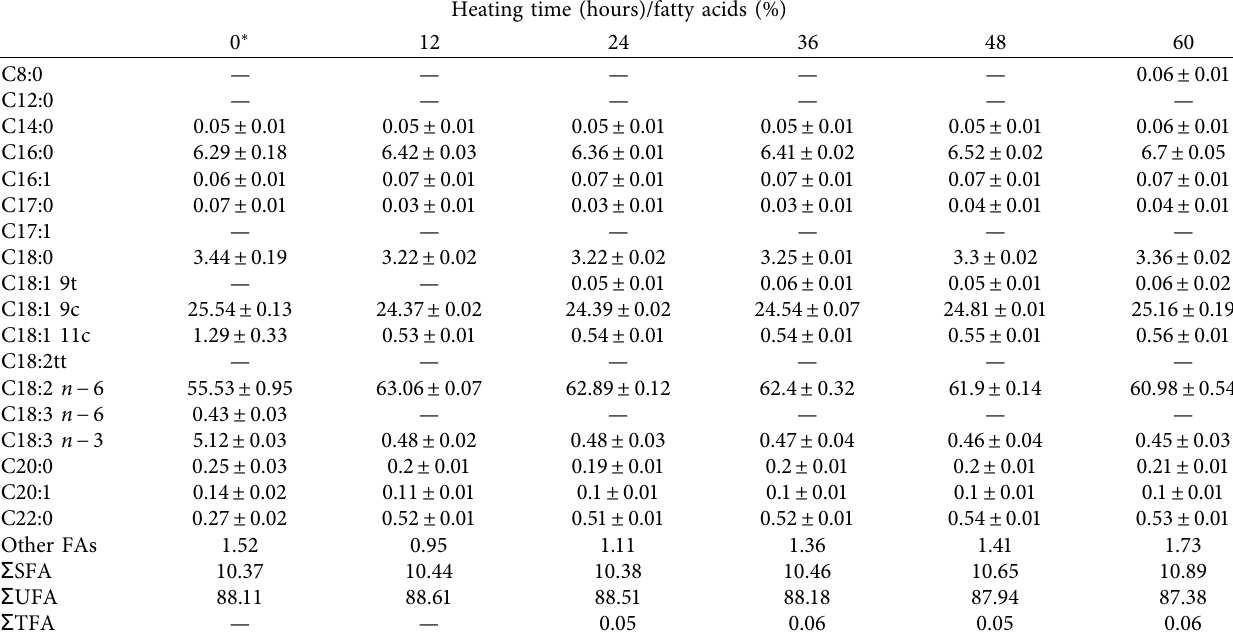
Table 2: Variation of fatty acids of sunflower oil under 150 ° C heating temperature at different heating times. Heating time (hours)/fatty acids